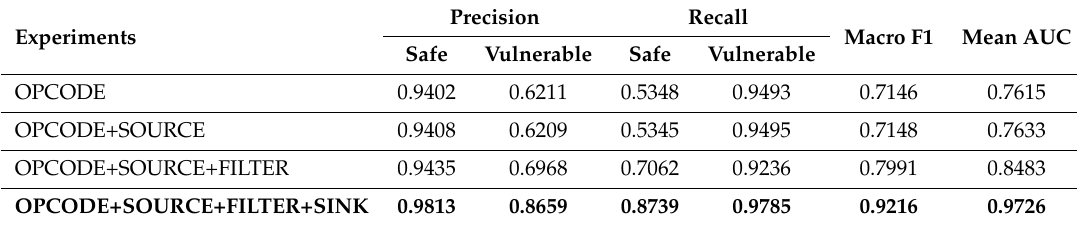
Table 4. Performance of different